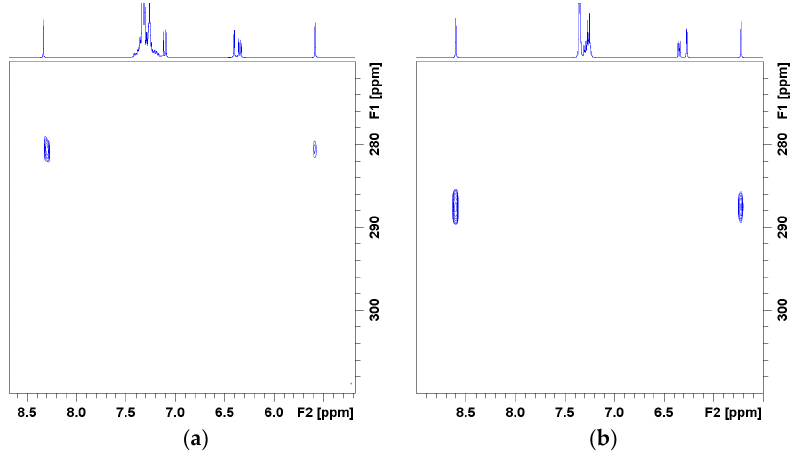
Figure D10. 1 H– 15 N HMBC NMR spectra of mOHsaladpm in ( a ) CDCl 3 and ( b ) DMSO-d 6 .